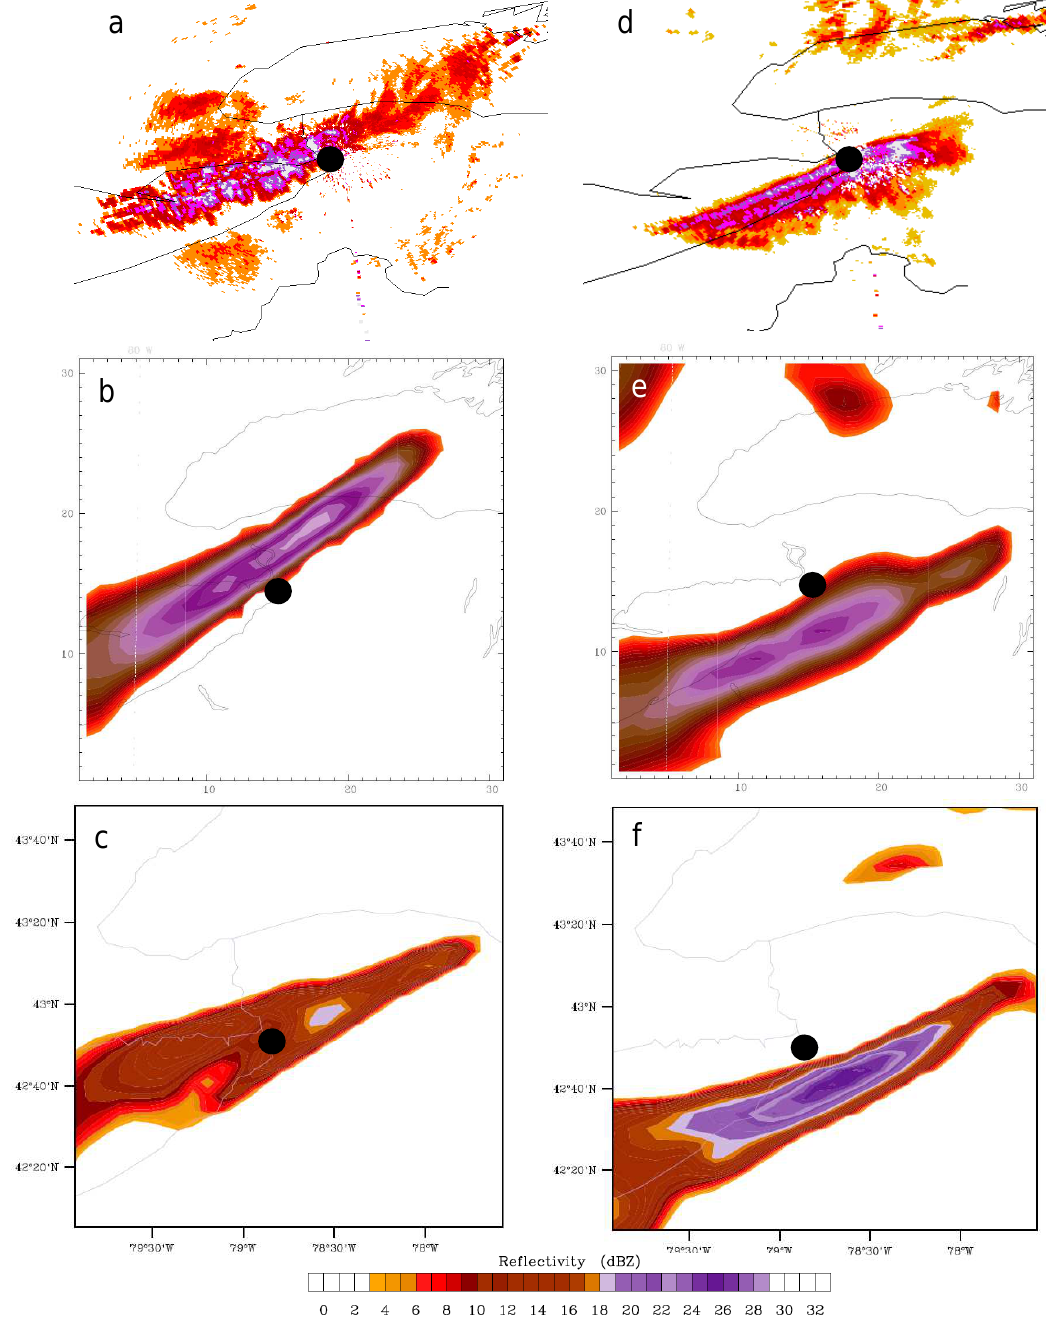
Figure 4. Radar images (domain 2, 9km resolution) from (a, d) observations in Bu ff alo, (b, e) MM5, (c, f) WRF for 24 December 2001, 12:00UTC (a–c) and 25 December 2001, 06:00UTC (d–f). The black dot indicates Bu ff alo.